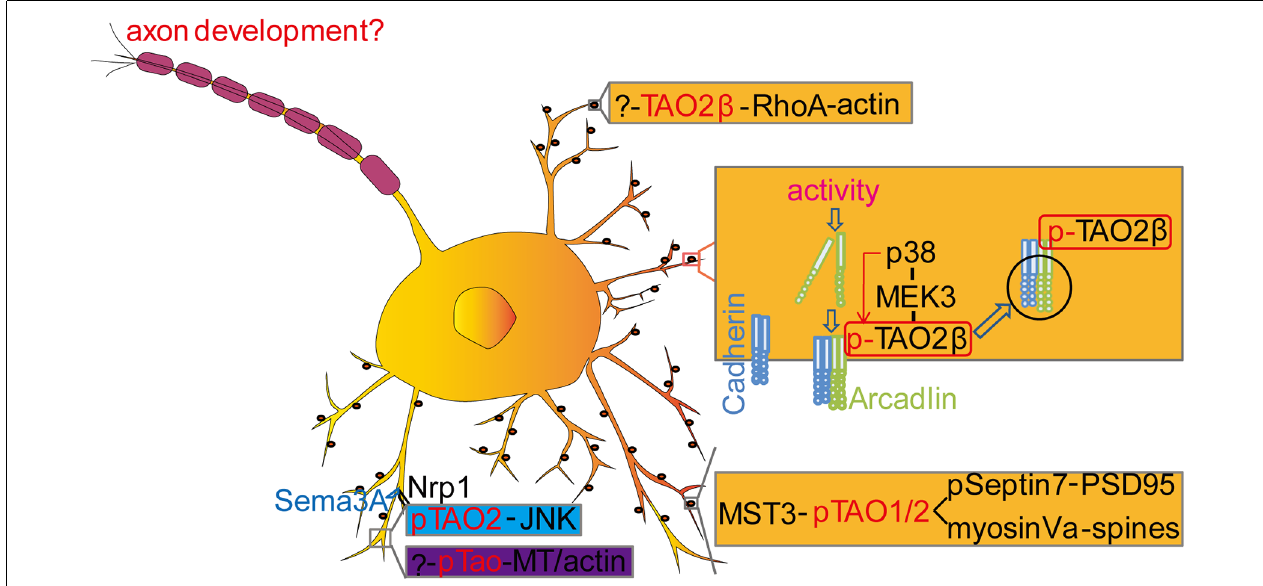
FIGURE 3 | Molecular mechanisms of Tao kinases in neurodevelopment. TAO2 could regulate dendrite development (blue labeled) and spine development (yellow labeled) with multiple signaling pathways. In Drosophila , Tao kinase regulated dendritic development is also indicated with an unknown upstream pathway [?-pTao-Microtubule (MT)/actin] (purple labeled). In addition, TAO2 functions downstream of BDNF to activate the JNK signaling cascade to regulate interneuron maturation during development. However, whether TAO kinases contribute to axonal development and the underlying mechanisms remains to be determined. See details in the main